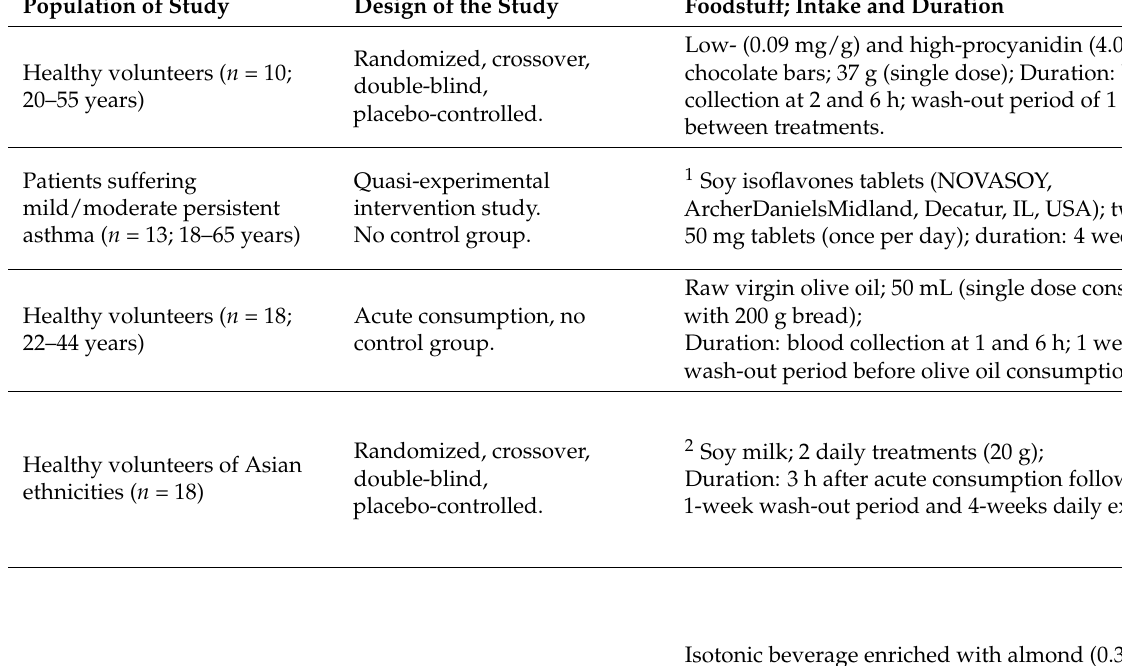
Table 1. Human studies describing the effects of the consumption of (poly)phenols on 5-LOX and its products. Main Outcomes